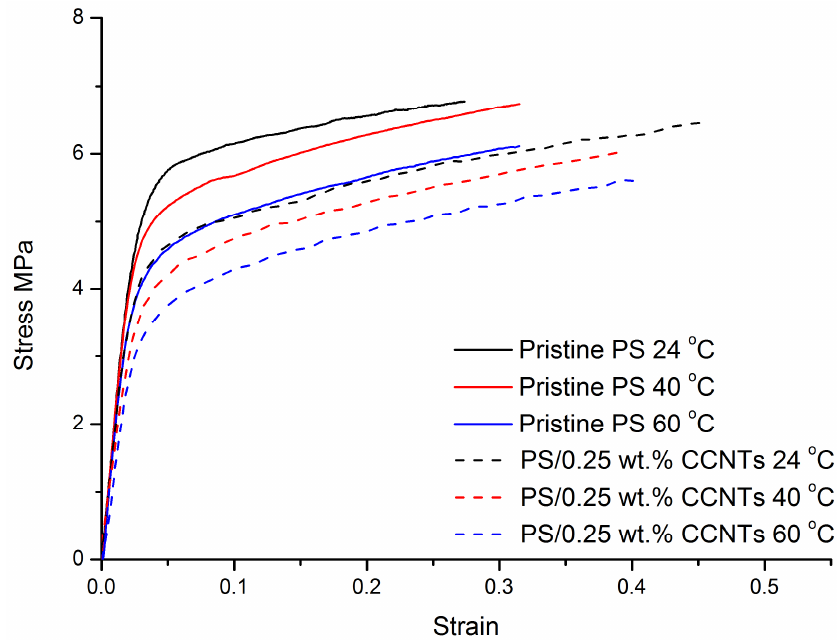
Figure 7. Engineering stress–strain curves of PS nanocomposite membranes with different contents of CCNTs or PCNTs at different temperatures and at an initial strain rate of 0.17/s.